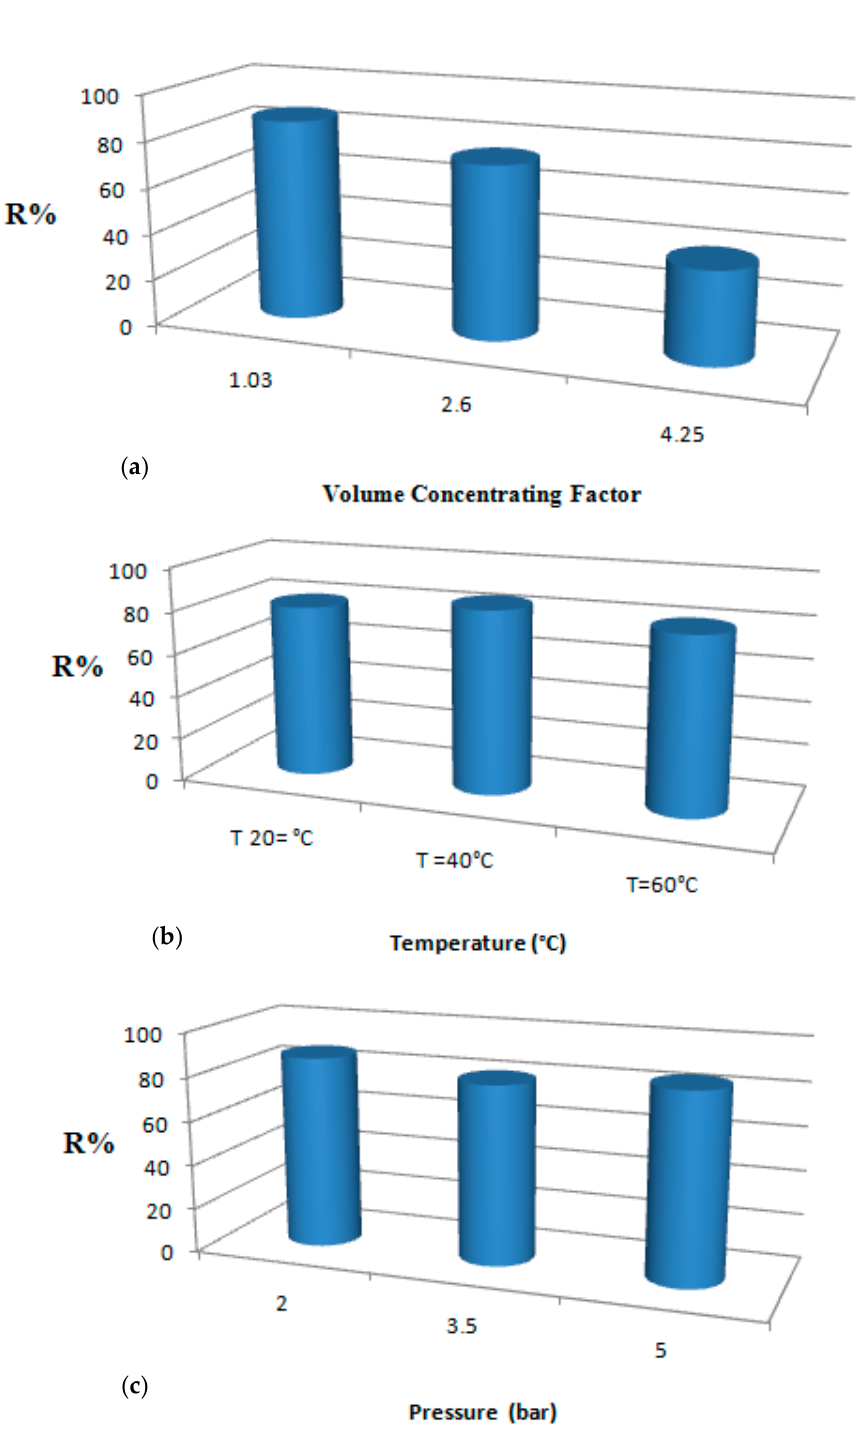
Figure 4. Variation of protein retention with VCF ( a ), temperature ( b ), and pressure ( c ).